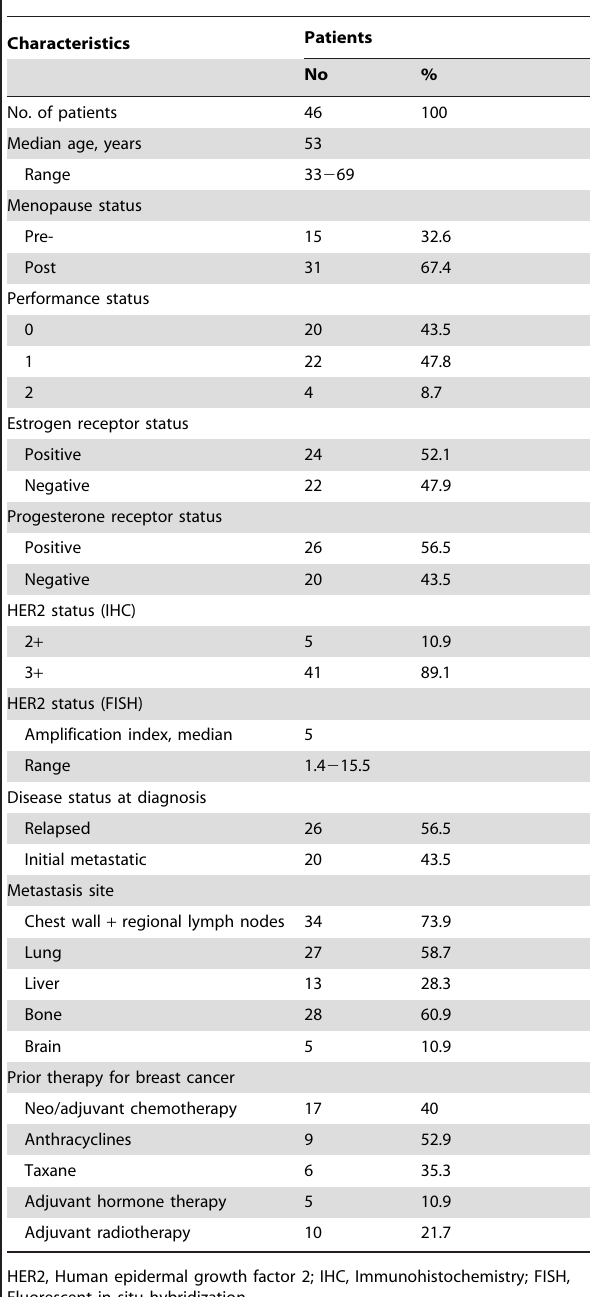
Table 1. Characteristics of the patients.